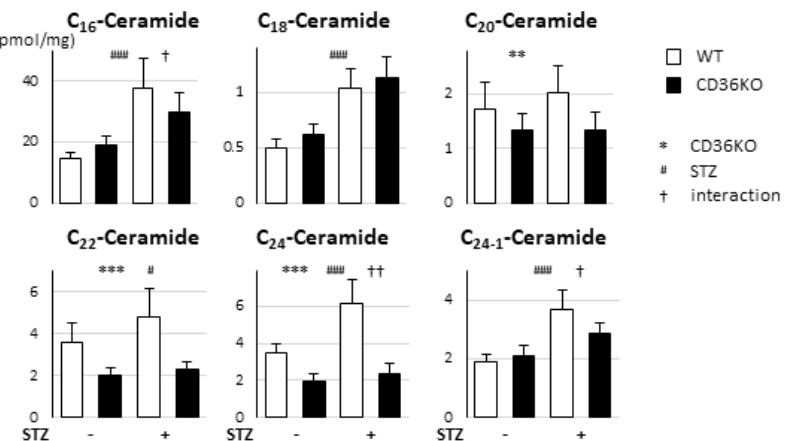
Figure 5. Accumulation of cardiotoxic lipids was not enhanced in CD36KO-STZ hearts compared to WT-STZ ones. Hearts were isolated after a 6 h fast. Ceramides with different lengths of FAs—C 16 , C 18 , C 20 , C 22 , C 24 and C 24:1 —were measured ( n = 5–7). ** p < 0.01, *** p < 0.001; main effect for genotype. # p < 0.05, ### p < 0.001; main effect for STZ treatment. † p < 0.05, †† p < 0.01; interaction between genotype and STZ treatment.